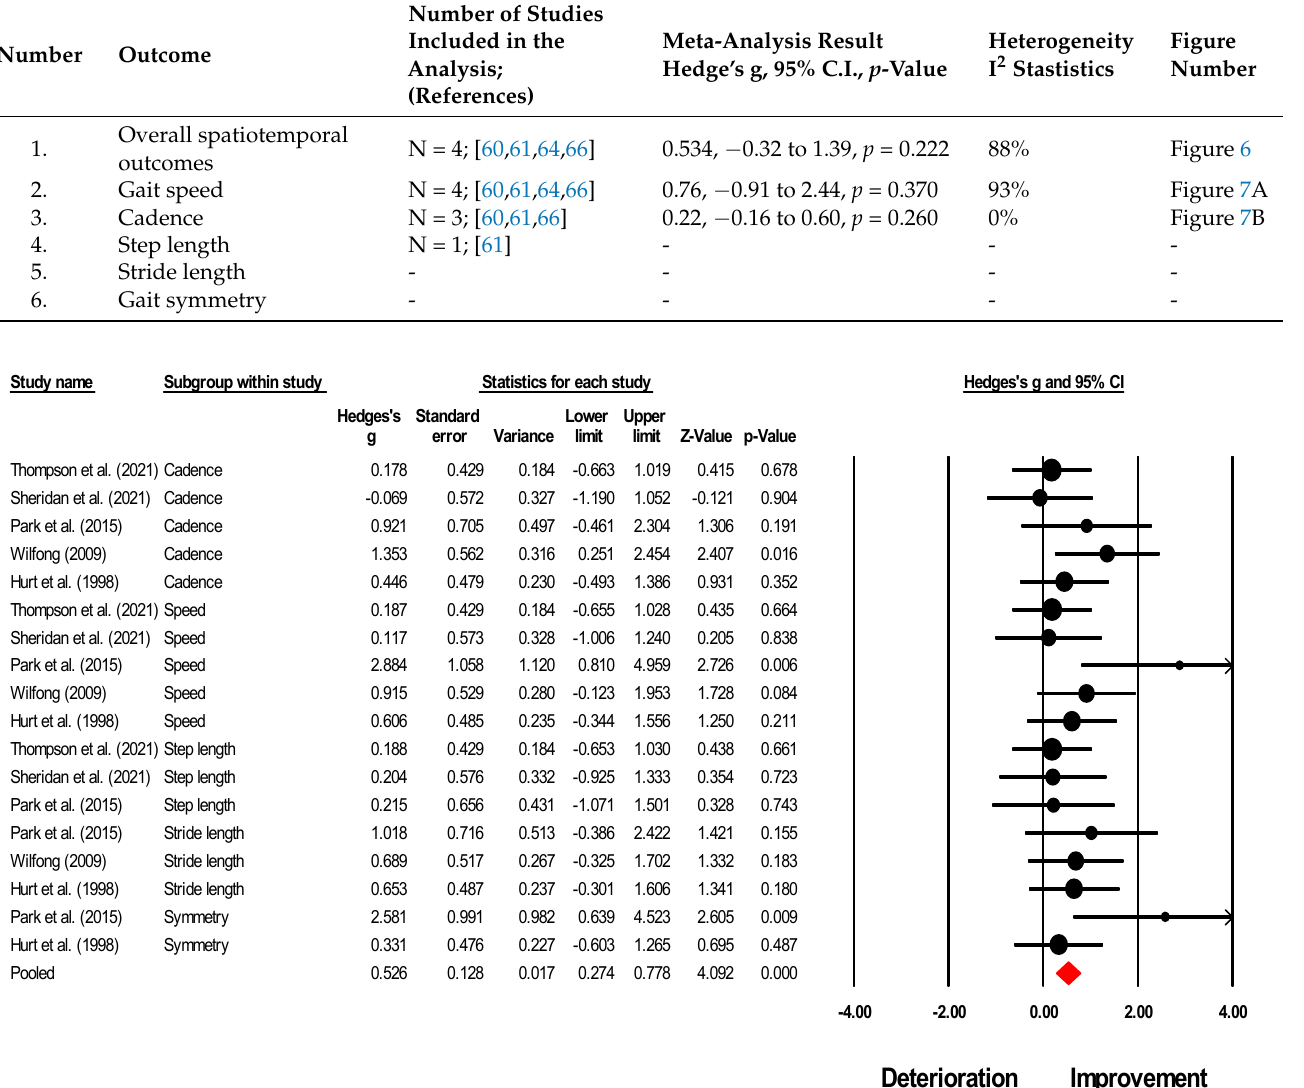
Table 5. Meta-analysis outcome for spinal cord injury.